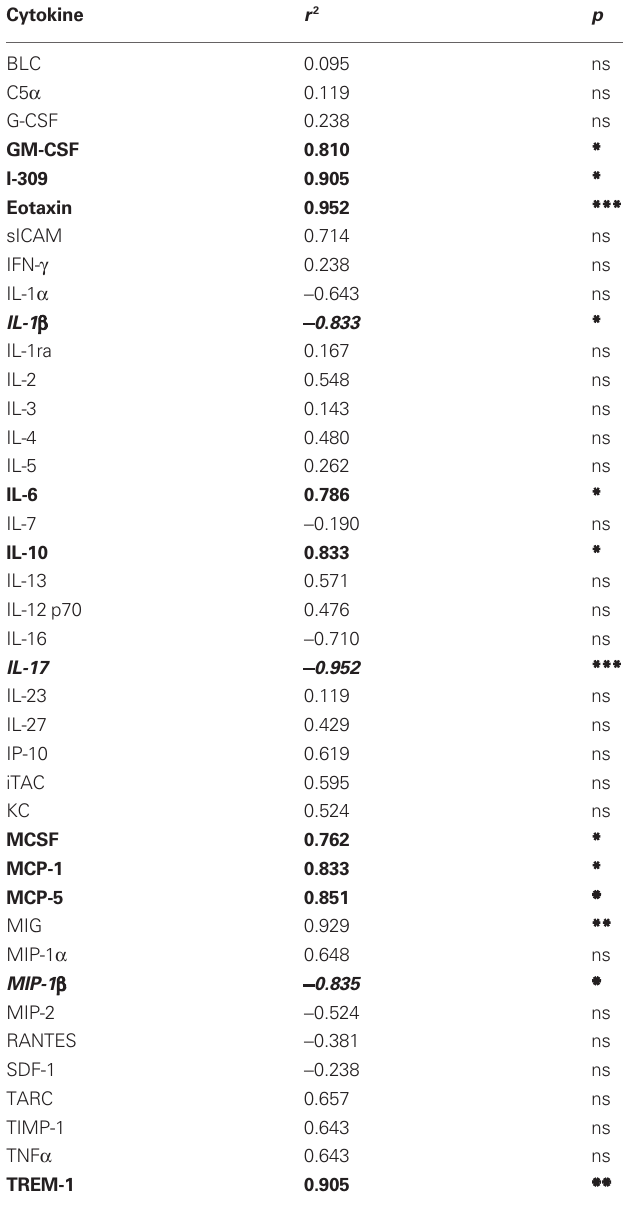
Table 1 | Correlation between cortical amounts of pSer396/404 tau and